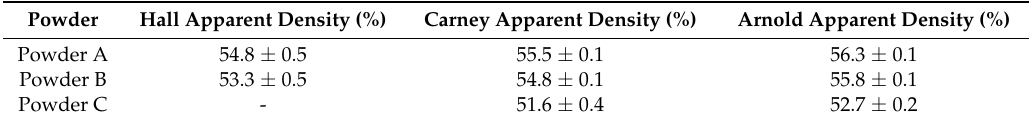
Table 3. Apparent density of powders A, B, and C estimated by the Hall and Carney funnels as well as the Arnold